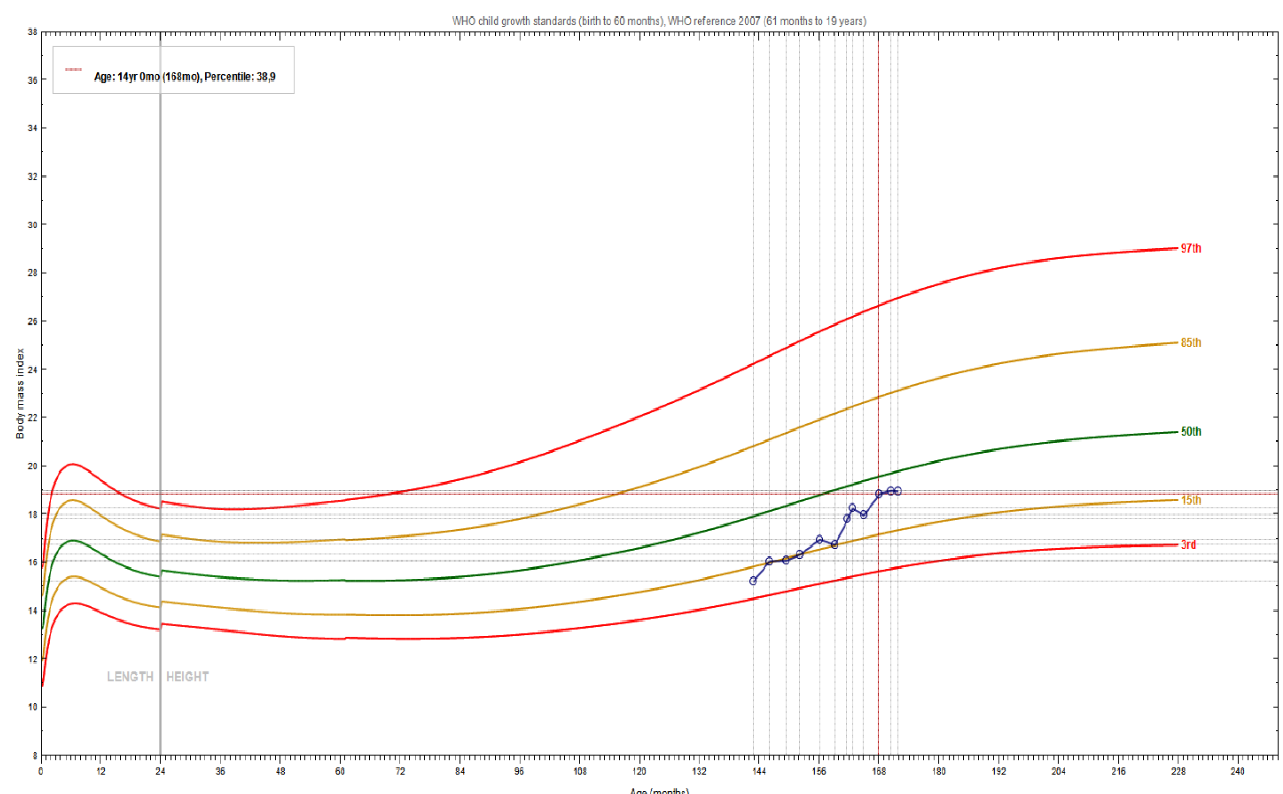
Figure 1. Improvement in the body mass index of the patient during the intervention.